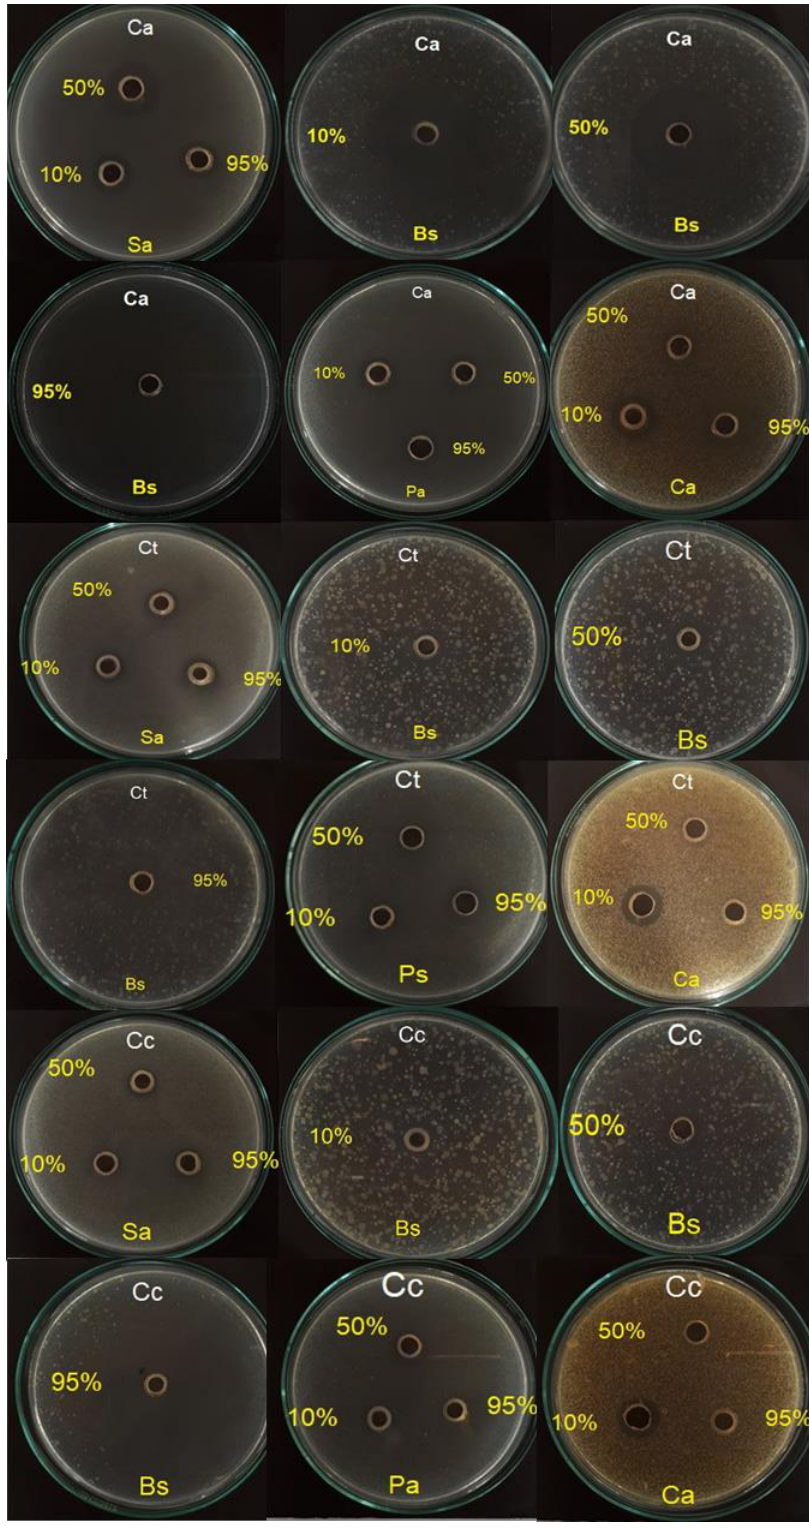
Figure 2. Antimicrobial activity of Croton species at different concentrations 10%, 50% and 95% by the agar diffusion method. The white acronym represents the analyzed plant species: Ca ( C. adipatus ); Ct ( C. thurifer ), Cc ( C. collinus ); while the yellow acronym represents microorganisms such as Sa ( S. aureus ), Bs ( B. subtilis ), Pa ( P. aeruginosa ), and Ca ( C. albicans ); the yellow letters represent the concentration percentages of each essential